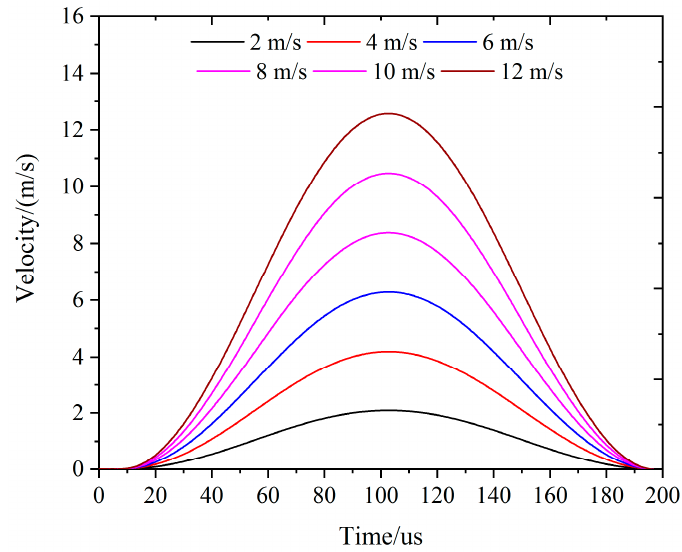
Figure 19. Incident wave with different amplitudes.